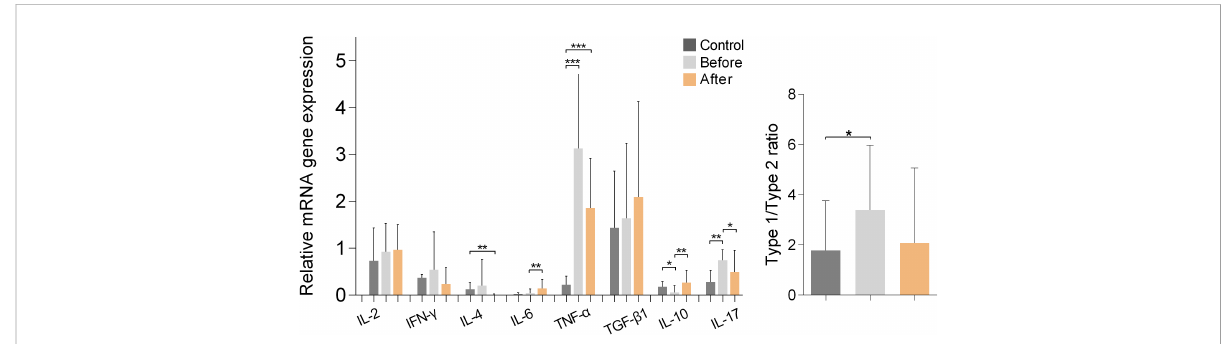
FIGURE 5 Relative mRNA gene expression of cytokines in PBMCs from marathon runners before and after the race and from control subjects. Data are shown as mean (SD). Type-1/type-2 ratio: [IL-2+IL-6+IL-17+IFN- g +TNF- a ]:[IL-4+IL-10+TGF- b 1]. *p<0.05, **p<0.01,